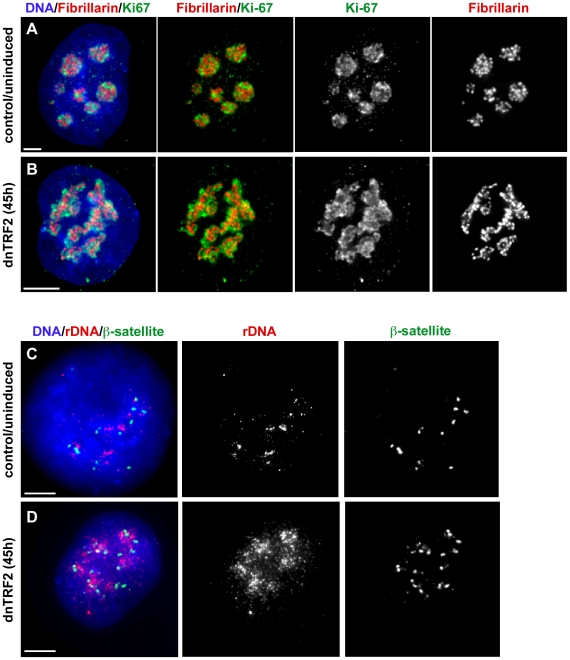
dnTRF2 expression alters nucleolar and acrocentric short arm architecture.Nucleoli in 3-D preserved cells isolated after 45 hours of dnTRF2 expression were identified in intact nuclei using immunostaining for fibrillarin (red) and Ki-67 (green). (A) In control (uninduced) cells, the nucleolus appeared as multiple punctate lobes in which fibrillarin and Ki-67 were intertwined. (B) In cells expressing dnTRF2, nucleolar morphology was abnormal, appearing as unraveled “nucleolar necklaces” rather than punctate structures in the center of the nucleus. (C) FISH with ß-satellite and rDNA probes on interphase nuclei showed that acrocentric repeat arrays normally appeared as tightly compacted foci. (D) ß-satellite (green) and rDNA (red) arrays were widely dispersed throughout the nucleus after expression of dnTRF2 for 45 hours, indicating that telomere dysfunction induced by mutant TRF2 disrupted normal nuclear organization. Scale bars for all panels = 5 µm.